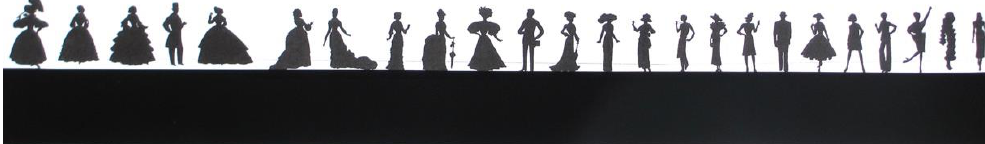
Figure 1. Fashion Timeline (Fashion Silhouettes from 1800–1990). Rachel Matthews 2018. Teaching resource used as a way for fashion students identify evolving womenswear silhouettes.